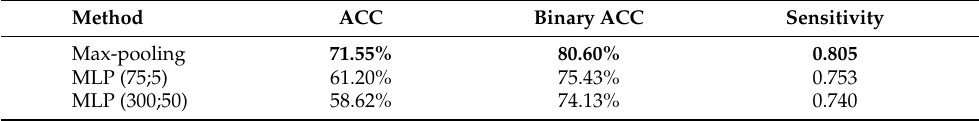
Table 5. Model performance evaluation on the TCGA test set. In bold are the best results per column.